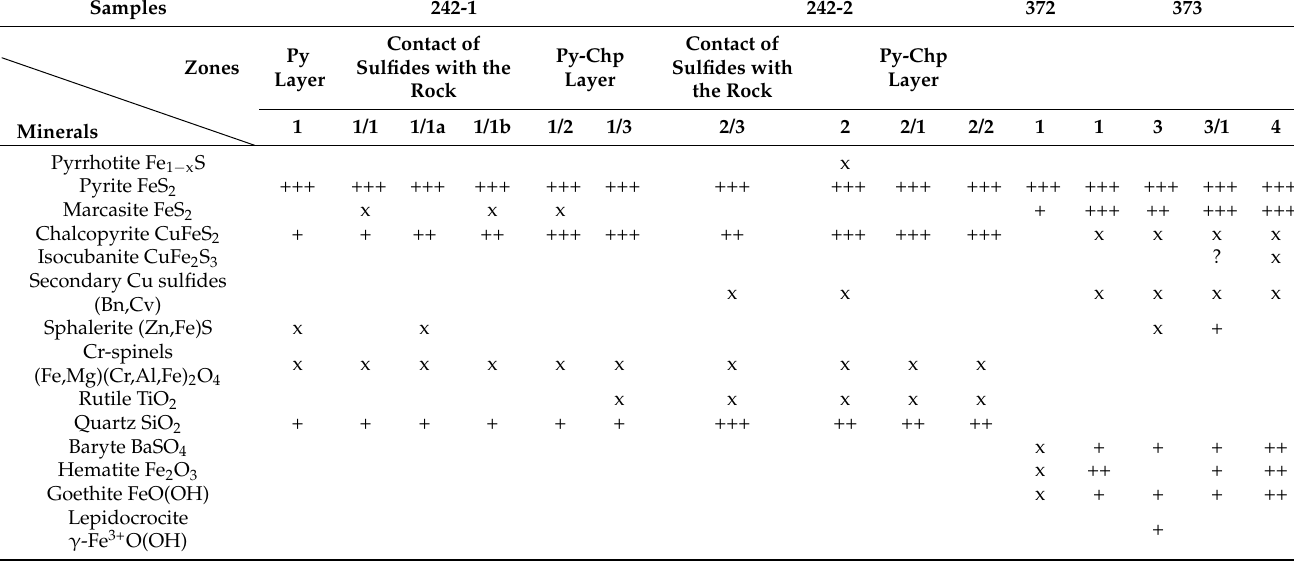
Table 1. Mineral composition of samples from Semenov-5 hydrothermal